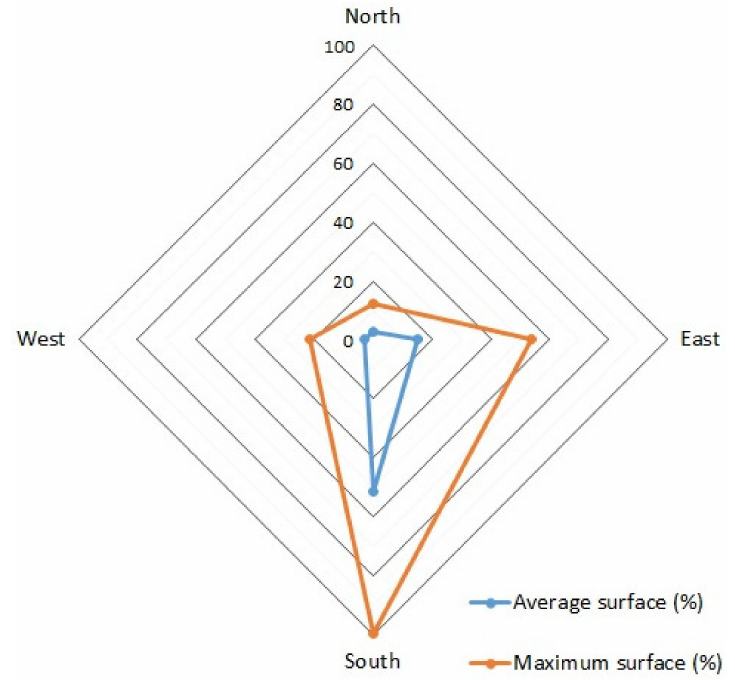
Figure 4. A more detailed analysis of the views according to their direction.